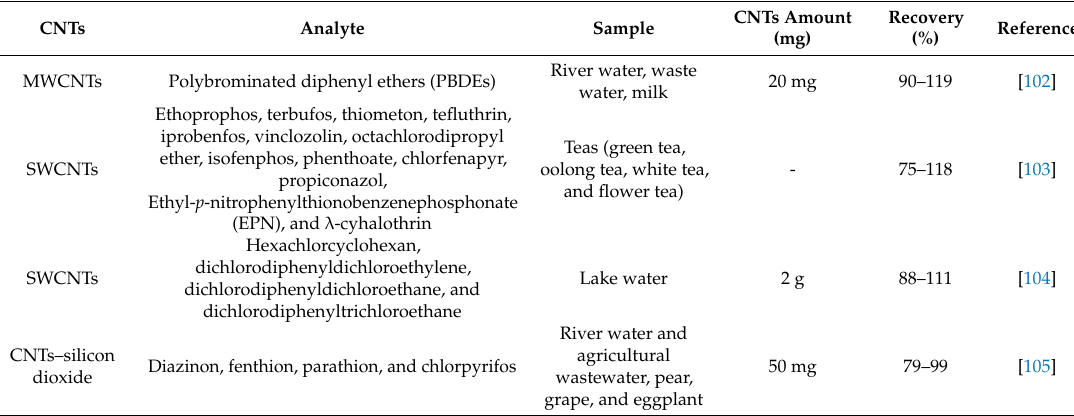
Table 5. The e ff ects of CNMs in the solid-phase micro-extraction (SPME)